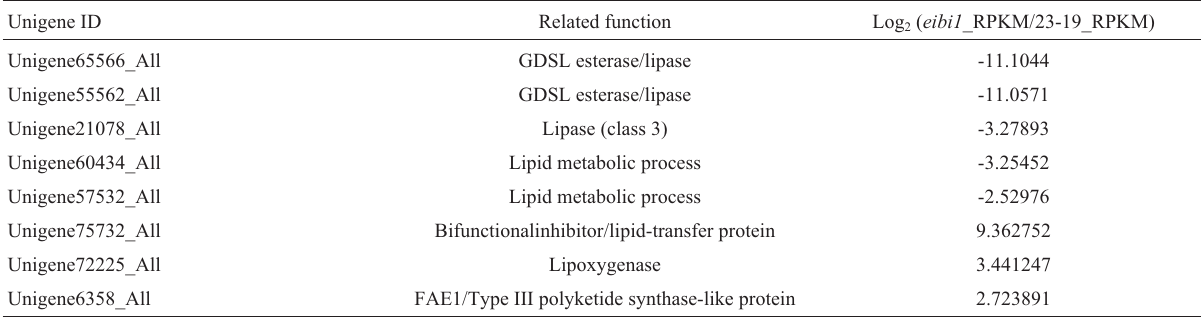
Table 2 - Relative expression of lipid metabolic process related